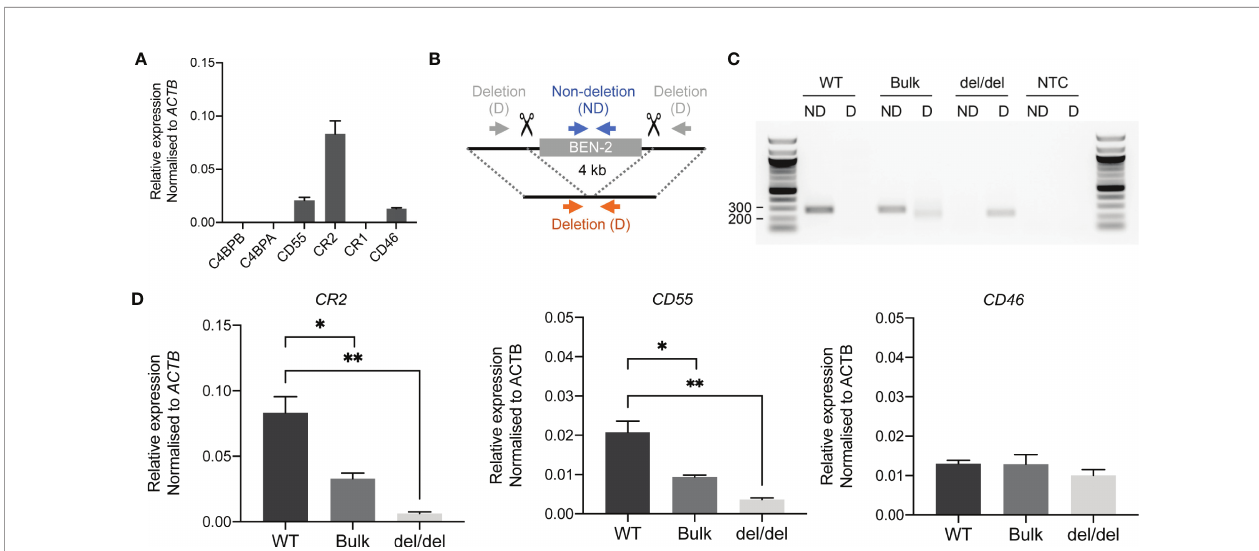
FIGURE 6 | CRISPR deletion of BEN-2 decreased CR2 and CD55 mRNA expression in the Raji mature B cell line. (A) Transcript abundance of RCA genes in Raji mature B cell line as measured by qPCR. Values were normalised to the b -actin gene ( ACTB ) using the D Ct method. Bars represent mean relative expression ± SEM from at least 3 biological replicates. (B) Schematic of enhancer deletion and screening strategy using CRISPR-Cas9. Deletion (4 kb) of BEN-2 was mediated by two gRNAs that cut either side of the enhancer region. Plasmids were modi fi ed from PX458 to express the two guides, Cas9 and a GFP marker. Screening was performed using PCR primers that fl ank the enhancer region (deletion; D) which amplify only in cases where a deletion has occurred (orange arrows). PCR primers that amplify within the enhancer region (non-deletion; ND) were used as a control (blue arrows). (C) PCR deletion screen of wild-type Raji DNA (WT), polyclonal GFP+ bulk population (bulk) and monoclonal single-cell clone containing a homozygous deletion of BEN-2 (del/del). PCRs were run alongside a no-template control (NTC). (D) Transcript abundance of RCA genes in TAD 1 ( CR2 and CD55 ) and TAD 2 ( CD46 ) were measured by qPCR. Values were normalised to the b -actin gene ( ACTB ) using the D Ct method. Bars represent mean relative expression ± SEM from 3 biological replicates. Asterisks represent statistically signi fi cant differences between WT, bulk and del/del samples (* p < 0.05, ** p ≤